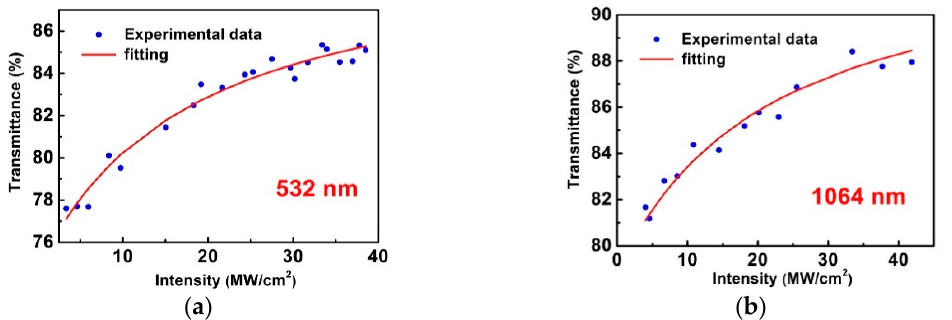
Figure 2. Transmittance versus incident power intensity for Si nanosheets dispersion at ( a ) 532 and ( b ) 1064 nm.